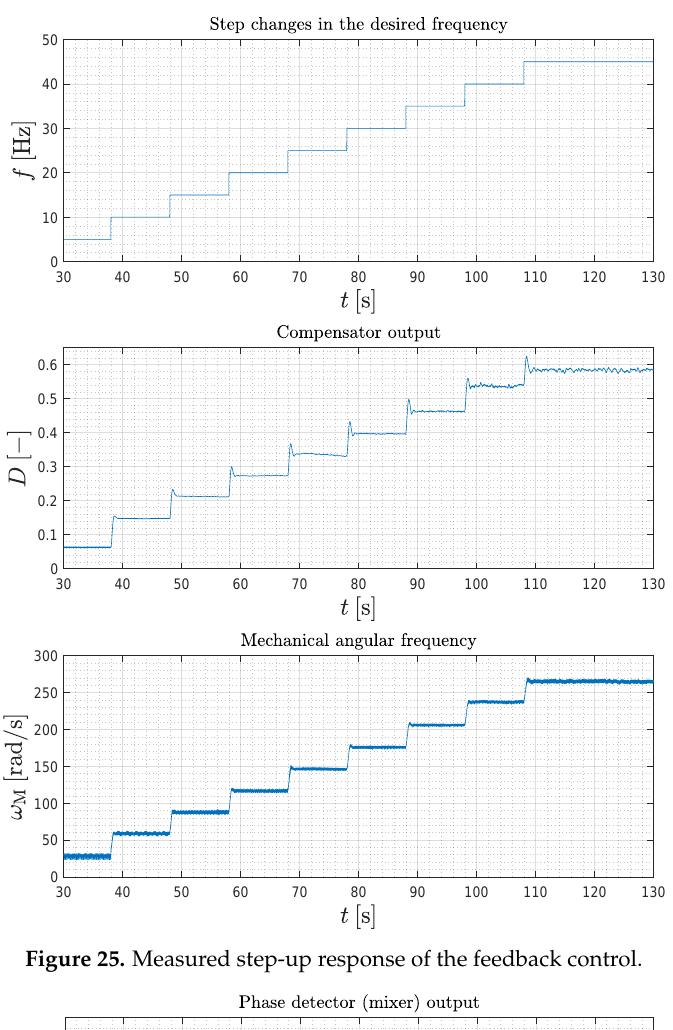
Figure 25. Measured step-up response of the feedback control.